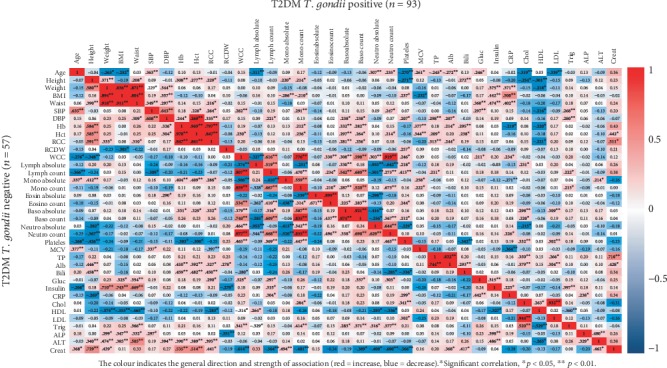
Correlation heat map with Pearson correlation coefficient values displaying the interrelationships between 37 laboratory and anthropometric parameters in T2DM subjects with and without T. gondii infection. BHS, Western Australia.